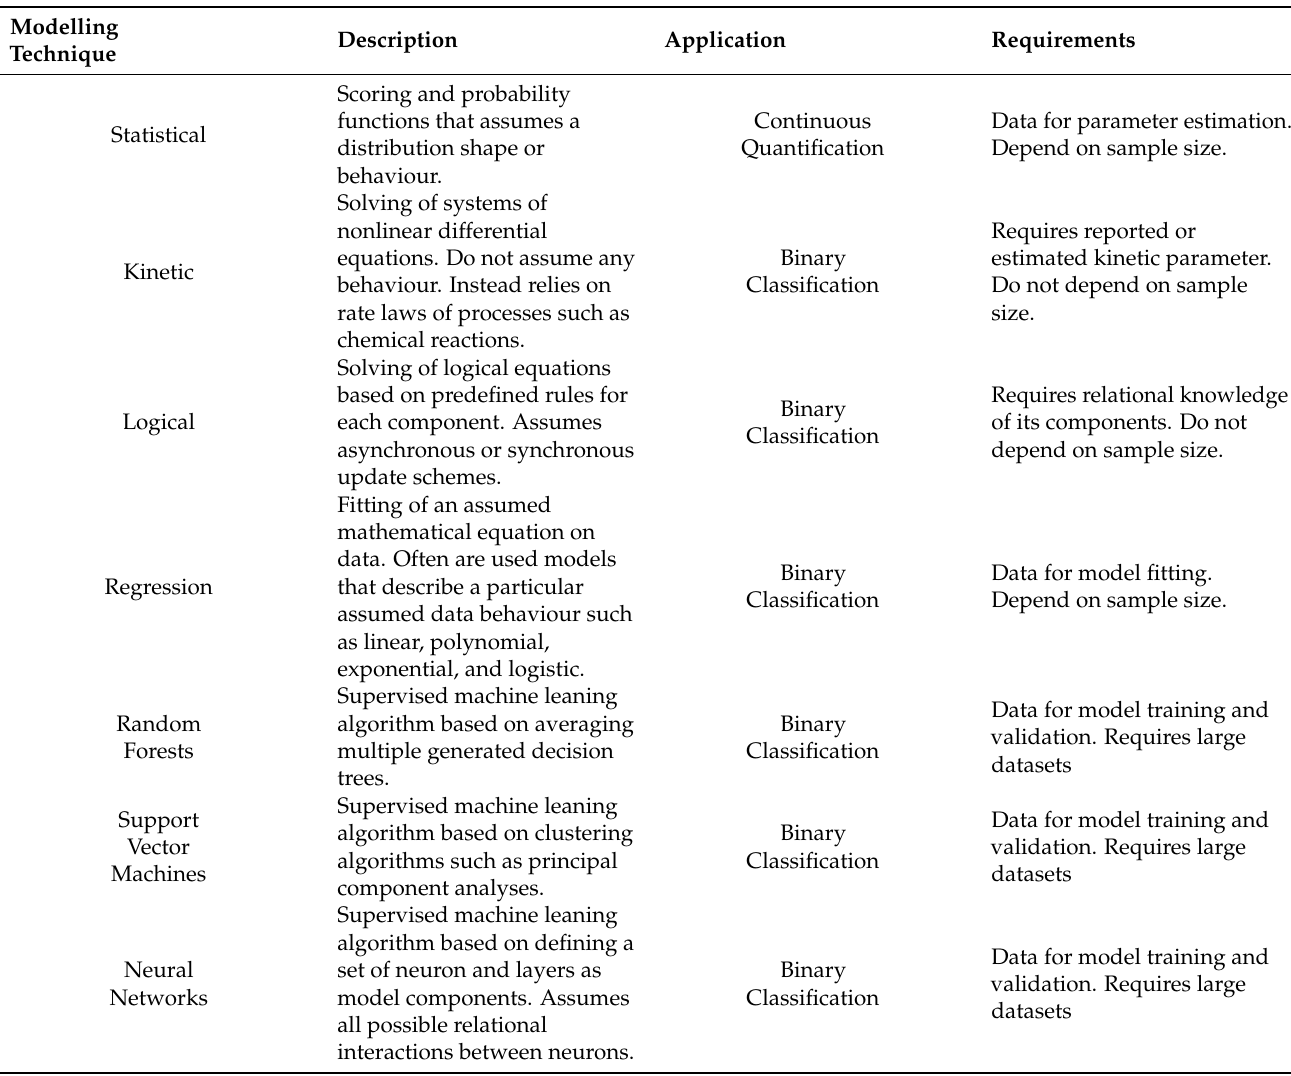
Table 1. Often used modelling techniques in clinical bioinformatics and their main